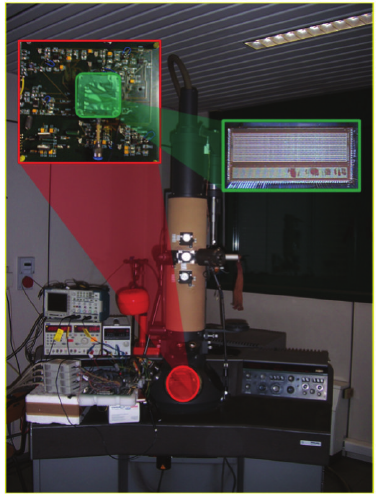
Figure 31: The transmission electron microscope (TEM), board and chip used in the